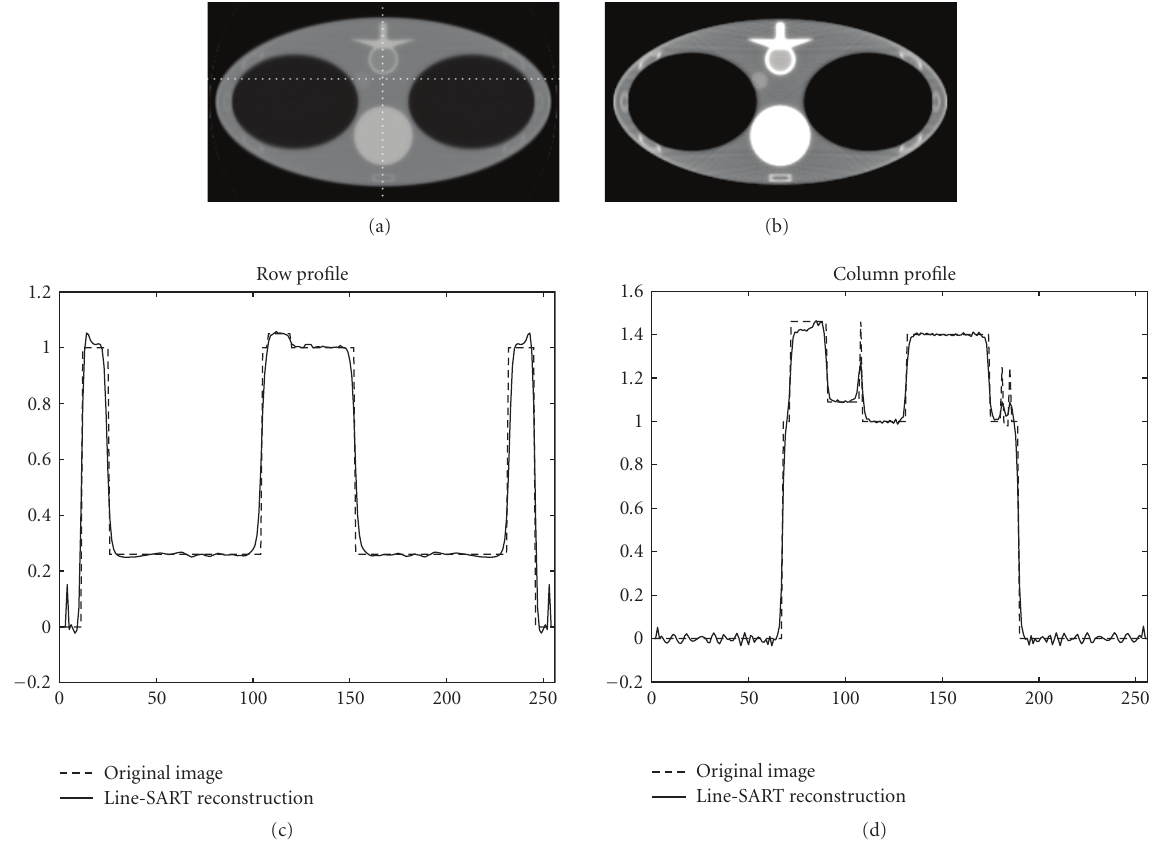
Figure 3: Line SART reconstructed images after 100 iterations using a line source of length 3cm at two di ff erent display windows with profiles along the dotted line. (a) Reconstructed image at a display window of [0,2]. (b) Reconstructed image at a display window of [0 . 8,1 . 2]. (c) Profile of the row. (d) Profile of the